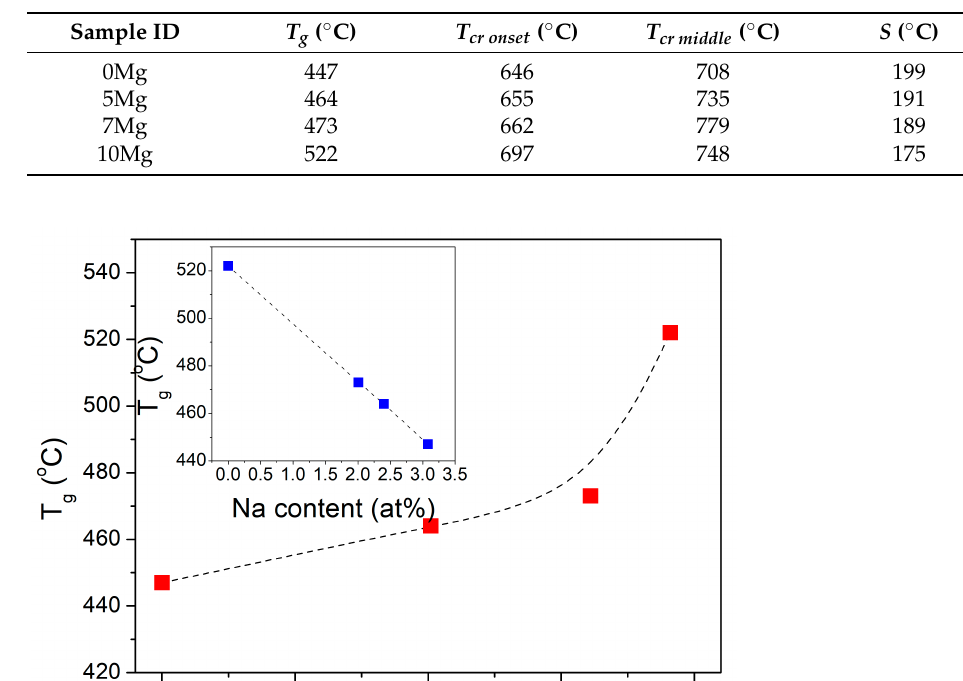
Table 4. DTA results of experimentally analyzed samples; glass transition ( T g ), exothermic process onset ( T cr onset ), crystalline peak position ( T cr middle ), and glass stability ( S ).